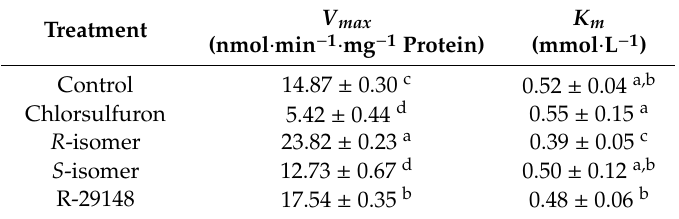
Table 3. E ff ects of safeners and chlorsulfuron on the kinetic parameters of GST in